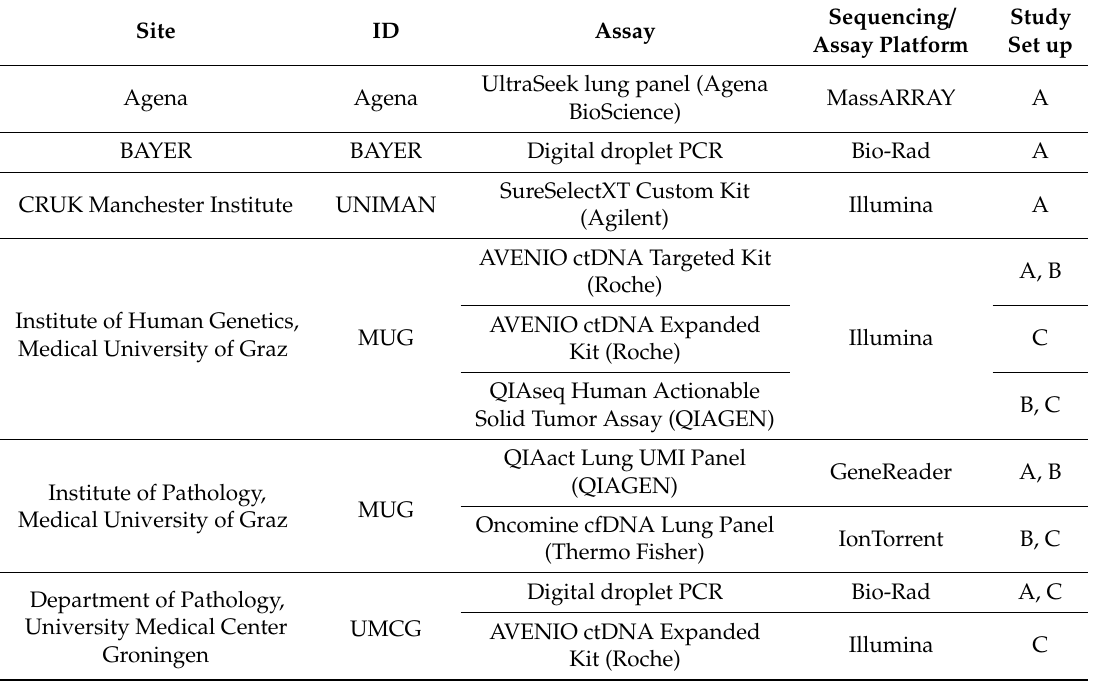
Table 2. Participating Cancer-ID sites and performed mutation analysis assays. Site